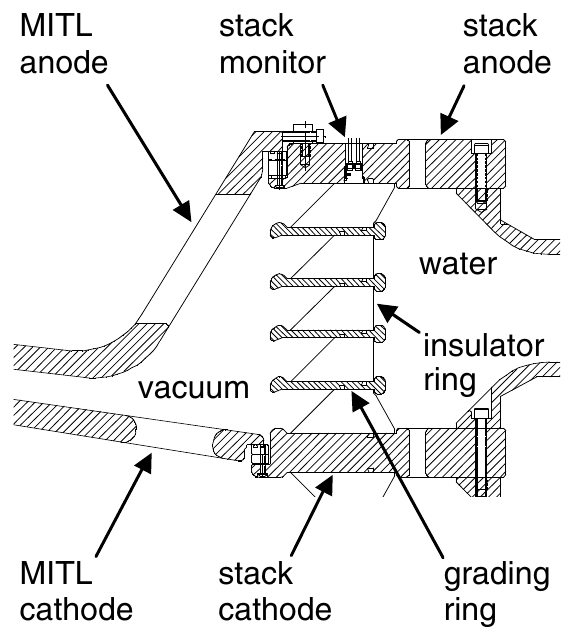
FIG. 2. One of the four insulator stacks of the 20-MA, 50- TW Z pulsed-power accelerator. The stack consists of five 45 (cid:1) 5.72-cm-thick, 1003-cm-circumference Rexolite insulator rings connected in series, and forms part of the accelerator’s vacuum interface. The figure shows the anode and cathode of the magnetically insulated transmission line (MITL) that is normally connected to the stack. The hardware is cylindrically symmetric about an axis to the left of the figure. Six D -dot and three B -dot monitors are located in the stack anode at nine azimuthally equidistant locations; an outline of one of the monitors is shown here.